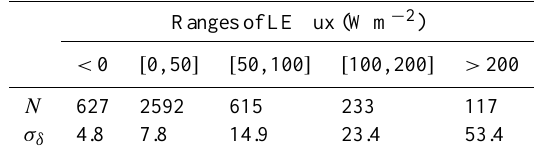
Table C1. Standard deviation ( σ δ ) of the random error of the LE measurements computed for distinct classes of LE values. N is the number of measurement pairs used to estimate the random